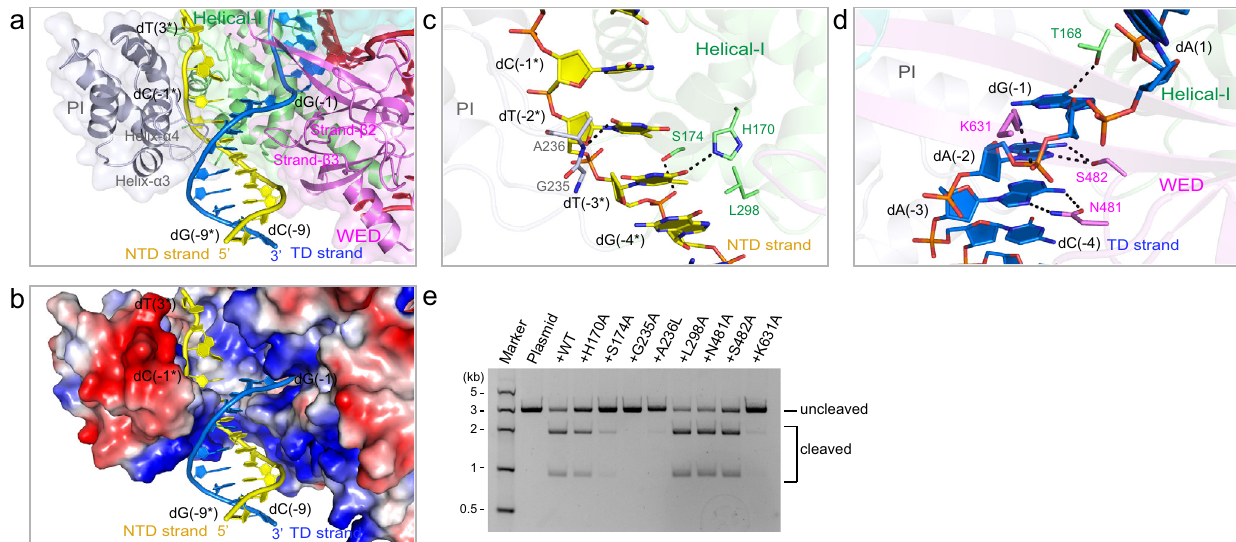
Fig. 2 Recognition of the PAM duplex. a Recognition of the PAM duplex in the Cas12i1 pre-cleavage R-loop complex and the PAM-interacting cleft formed by the Helical-I, PI, and WED domains. The loop between strands β 2 and β 3 of the WED domain inserts into the major groove of the PAM duplex, and another loop between helices α 3 and α 4 in the PI domain inserts into the minor groove of the PAM duplex. b Electrostatic potential surface of the PAM- interacting cleft. Red, white, and blue indicate negative, neutral, and positive electrostatic potential surfaces, respectively. c Recognition of the NTD strand in the PAM duplex. d Recognition of the TD strand in the PAM duplex. e Agarose gel demonstrating the cleavage of the linearized plasmid by wild-type Cas12i1 and the mutants in complex with crRNA. The cleavage assays were repeated three times independently to con fi rm the repeatability and source data are provided as a Source Data fi